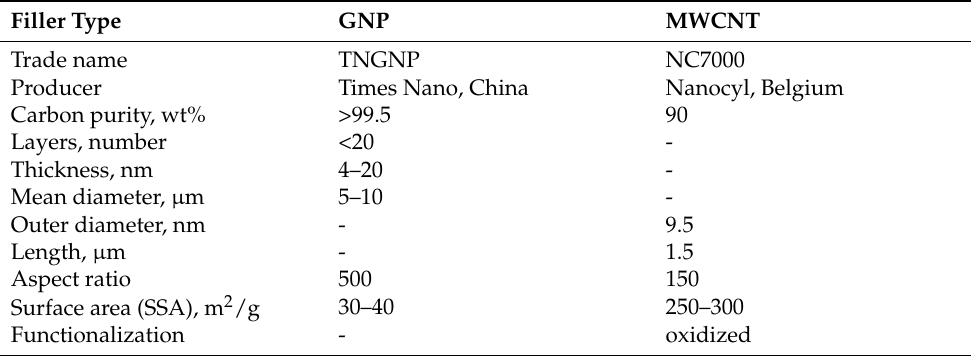
Table 1. Characteristics of the nanofillers, GNP and